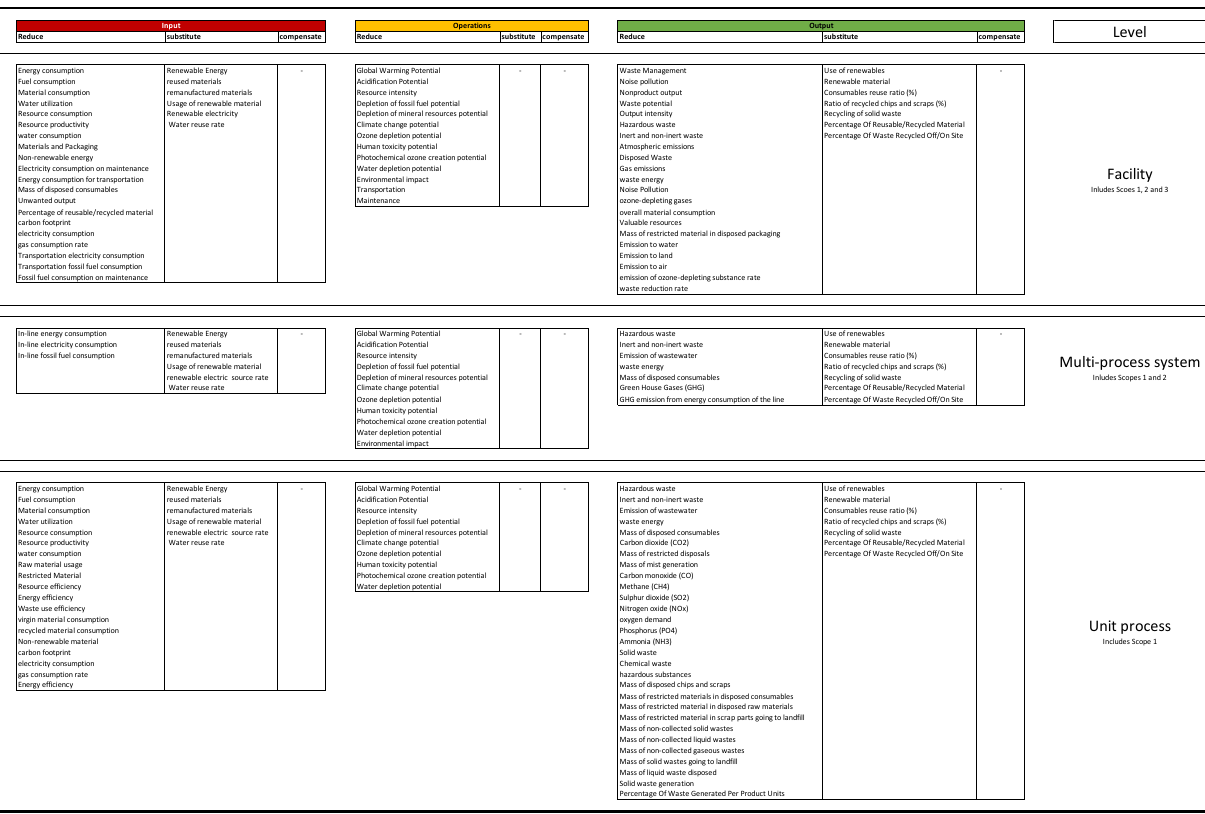
Figure A1. The collected metrics and the categorisation exercise performed as a part of the study to create initial knowledge database. Total number of metrics collected: 147, after removing duplicates: